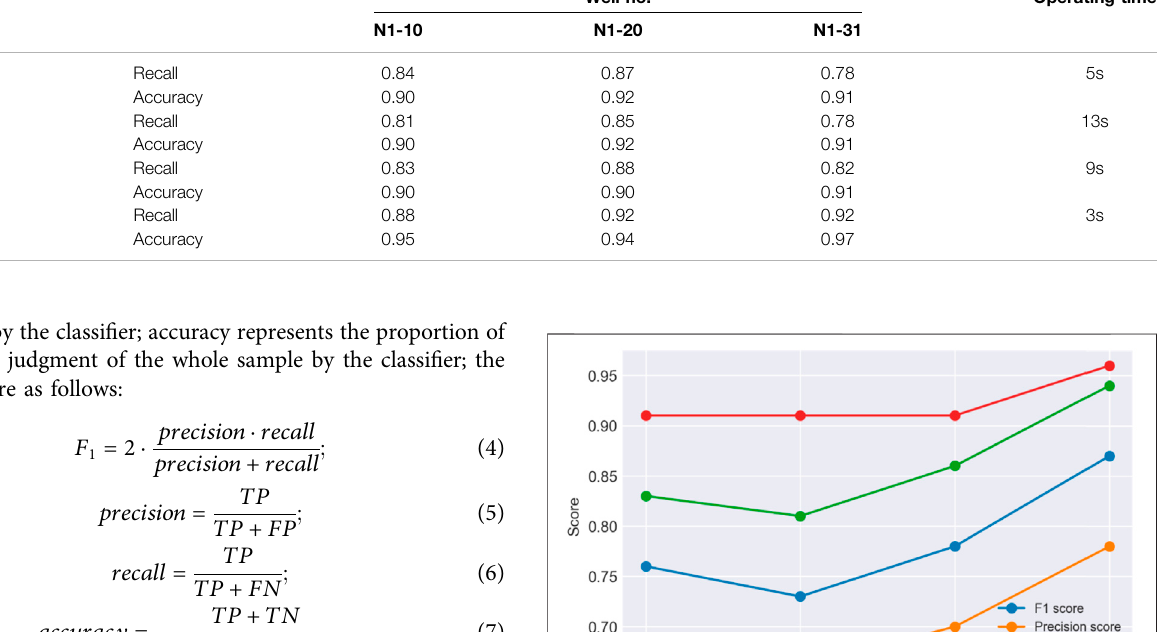
TABLE 3 | Comparison of LR, SVM, RF, and XGBoost algorithms. Algorithm Well no.